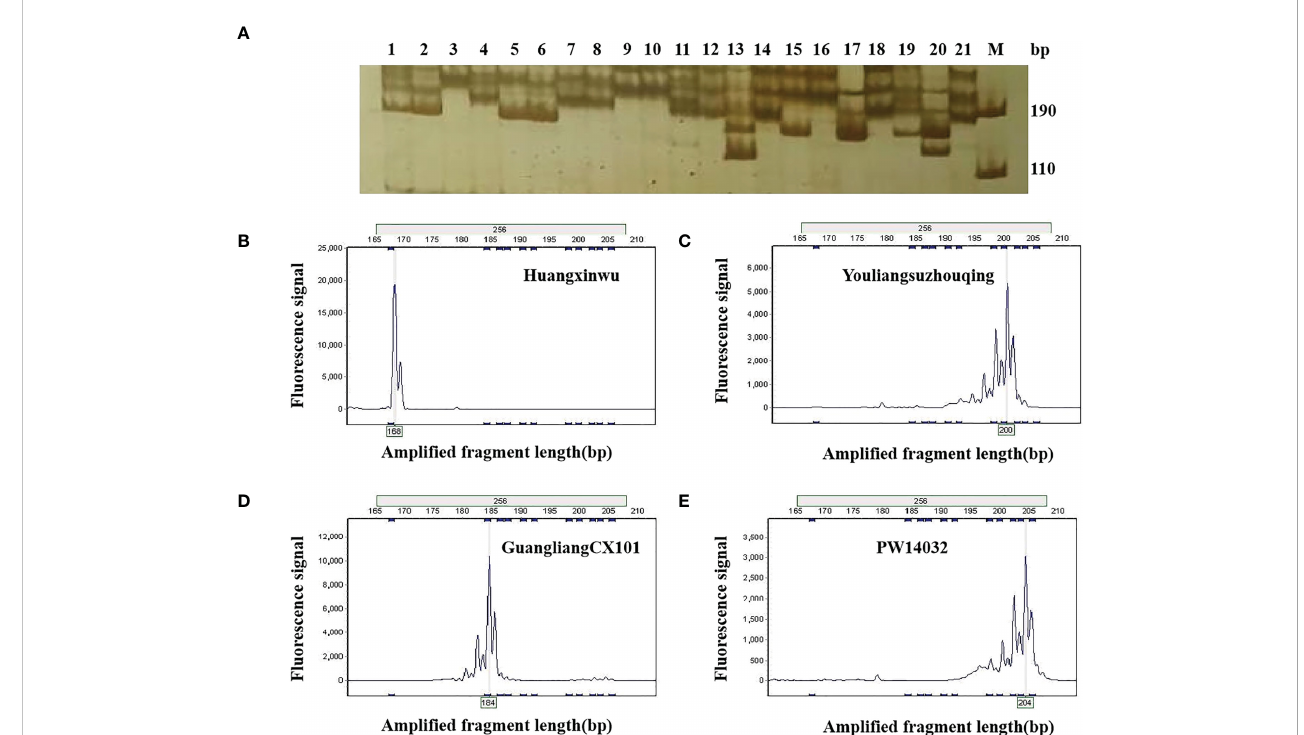
FIGURE 2 Allelic variation in 21 non-heading Chinese cabbage varieties using by primer SSR256. (A) Allelic variation in 21 varieties using PAGE. M , DNA marker; the number 1 – 21 in Figure 1a corresponds to the variety number in Table S2. (B – E) show the allelic variations in varieties 17, 9, 14, and 16 by fl uorescence capillary electrophoresis. PAGE, polyacrylamide gel